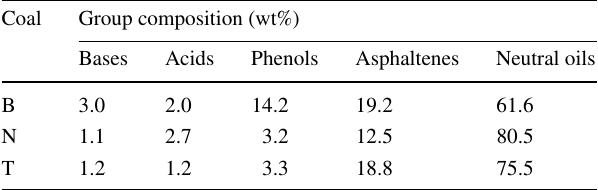
Table 8 Group composition of pyrolysis tars Coal Group composition (wt%)